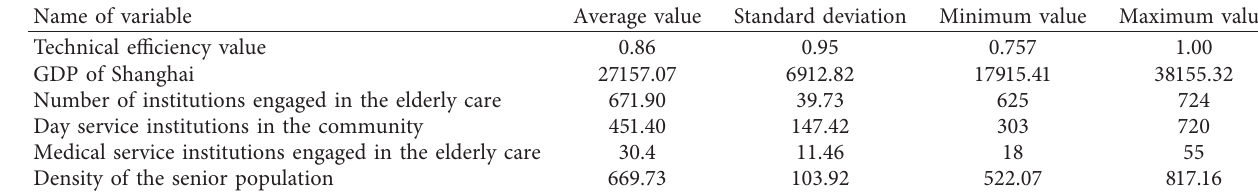
Table 5: Descriptive statistics of factors influencing resource allocation efficiency of the Shanghai pension service in